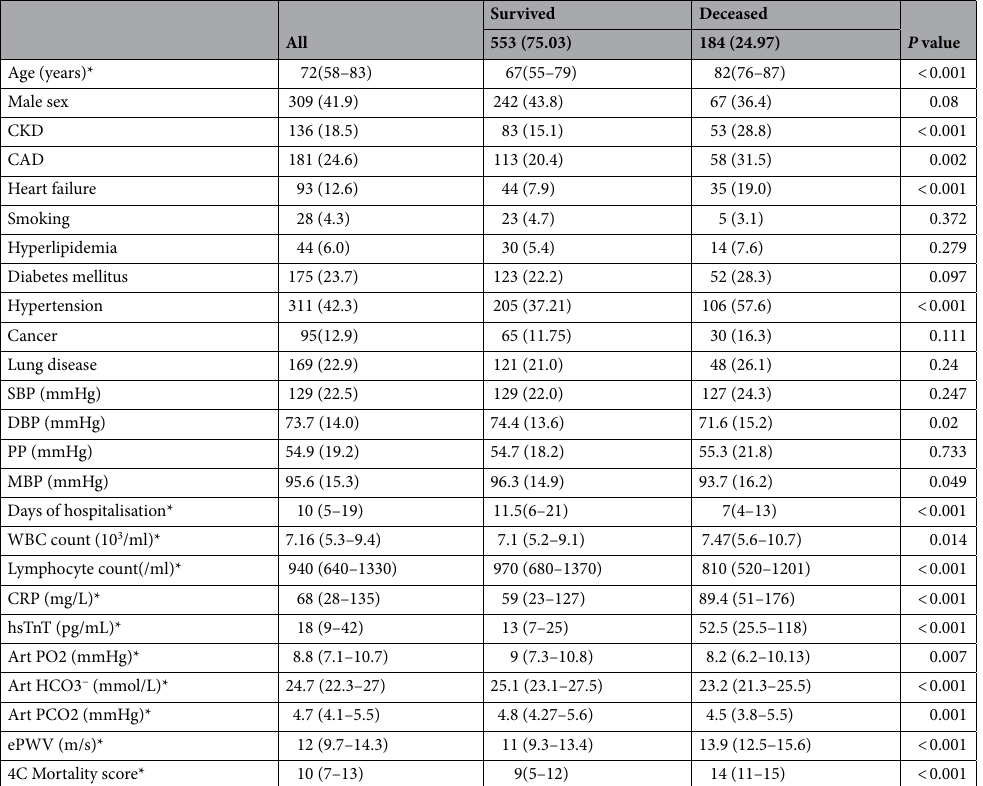
Table 1. Descriptive characteristics of the combined Newcastle and Pisa cohorts of hospitalised patients with COVID-19. Values in parentheses signify SD for continuous variables and percentages for ordinal variables. *Interquartile range for non-normal continuous variables. Lung disease was defined as at least one of: asthma, chronic obstructive pulmonary disease, interstitial lung disease, obstructive sleep apnoea, home nebuliser/ oxygen/non-invasive pressure support. CVD was defined as history of CAD and/or heart failure. CAD, coronary artery disease; CVD, cardiovascular disease CKD, Chronic Kidney Disease; SBP, Systolic blood pressure; DBP, diastolic blood pressure; PP, pulse pressure; MBP, mean blood pressure; ePWV, estimated pulse wave velocity; WBC, white blood cells CRP, C-reactive protein; hs-Troponin T, high sensitivity Troponin T; Art, arterial; 4C, Coronavirus Clinical Characterisation Consortium) International Severe Acute Respiratory Infection Consortium Clinical Characterisation